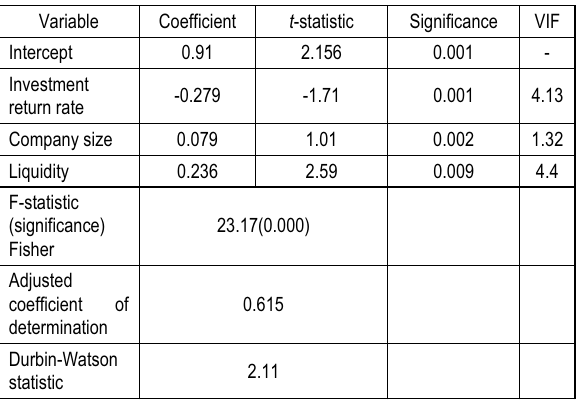
Table 5. Estimation of the model results